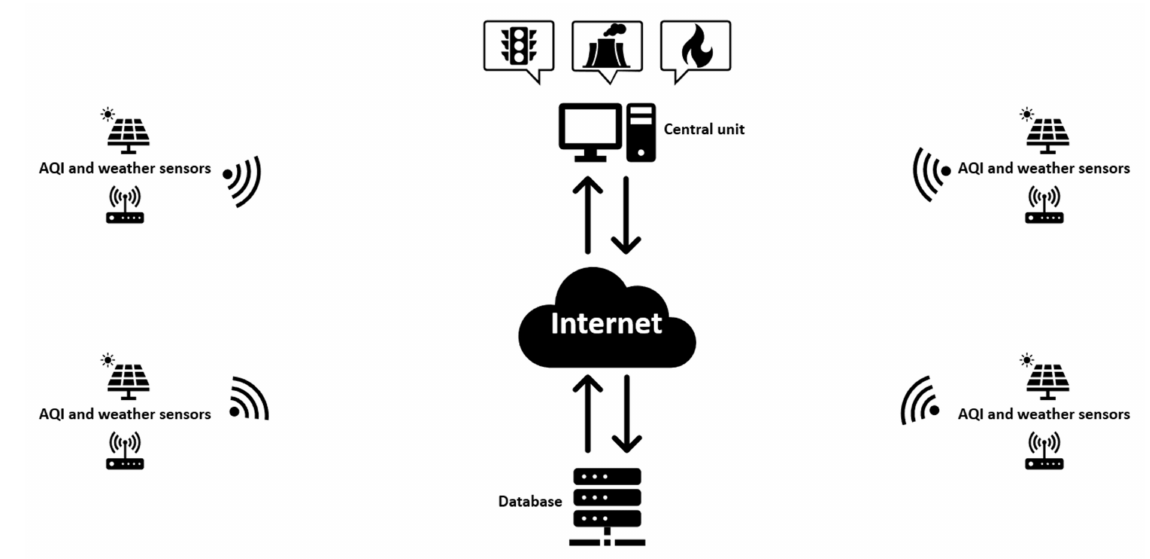
Figure 1. IoT block diagram of the physical